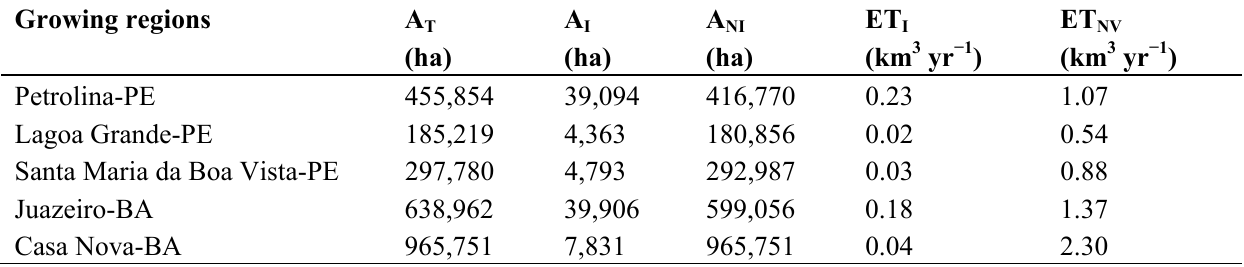
), irrigated (A ) and not irrigated (AN ) areas together with the annual Table 6. Total (A T I I actual evapotranspiration (ET) for irrigated crops (I) and natural vegetation (NV) in the growing regions comprised of the net of agro-meteorological stations in